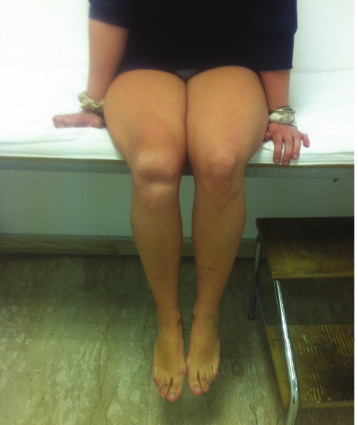
Figure 2: Active extension of the right knee was not possible although passive extension was complete.